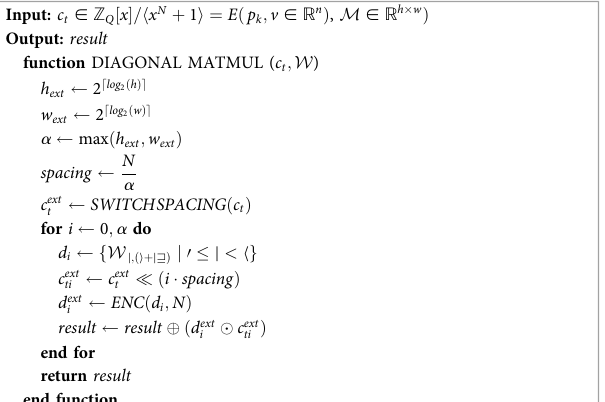
Algorithm 4 Diagonal Matrix Multiplication